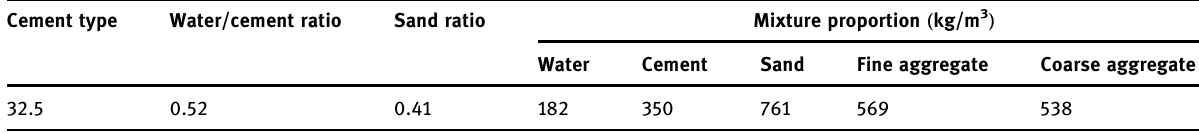
Table 1: Compositions of the concrete specimens Cement